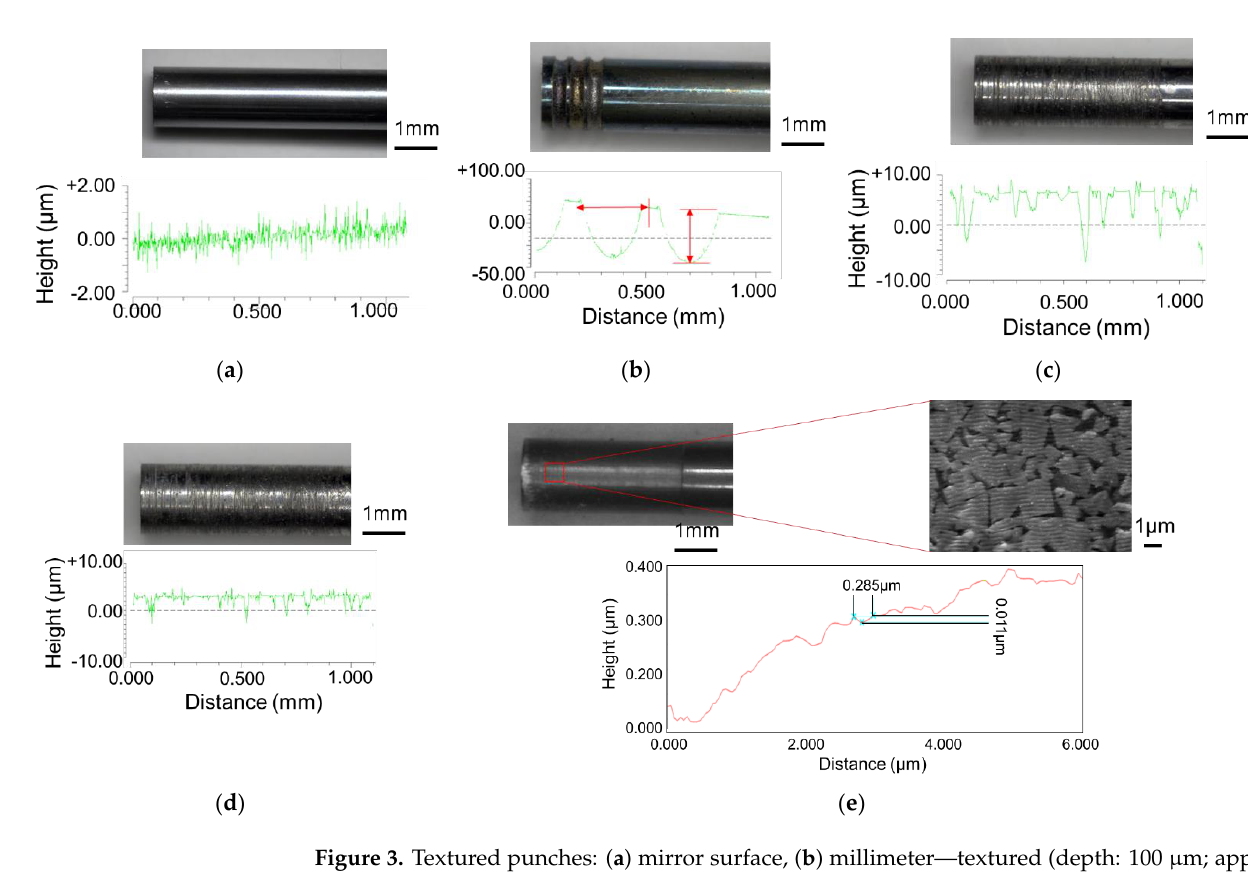
Figure 3. Textured punches: ( a ) mirror surface, ( b ) millimeter － textured (depth: 100 μm; approxi- mately 2 grooves/mm), ( c ) 10 μm － textured (depth: 10 μm; ~10 grooves/mm) , ( d ) 5 μm － textured (depth: 5 μm; approximately 10 grooves/mm), and ( e ) nanometer － textured (depth: 0.01 μm; ap- proximately 3 grooves/μm).